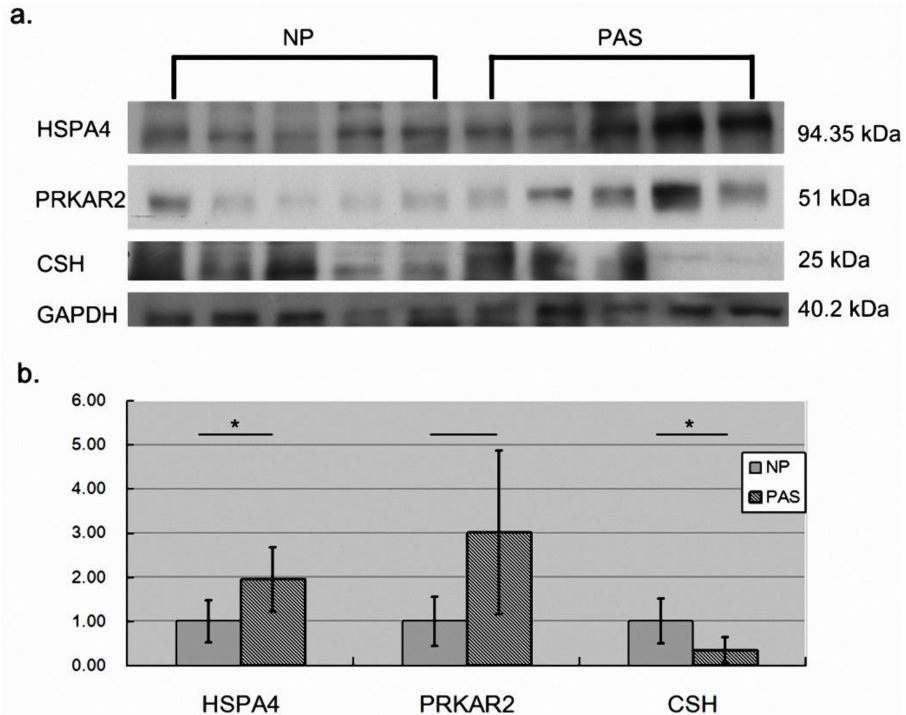
Figure 3. The results of western blot assays. We used western blot assays to validate the variations in protein abundance determined with 2D-DIGE. ( a ) The western blot results. ( b ) With GAPDH as an internal control, HSPA4 and CSH reached statistical significance ( n = 5). * denoted p -value < 0.05 ( t -test). Data was presented as the mean ±